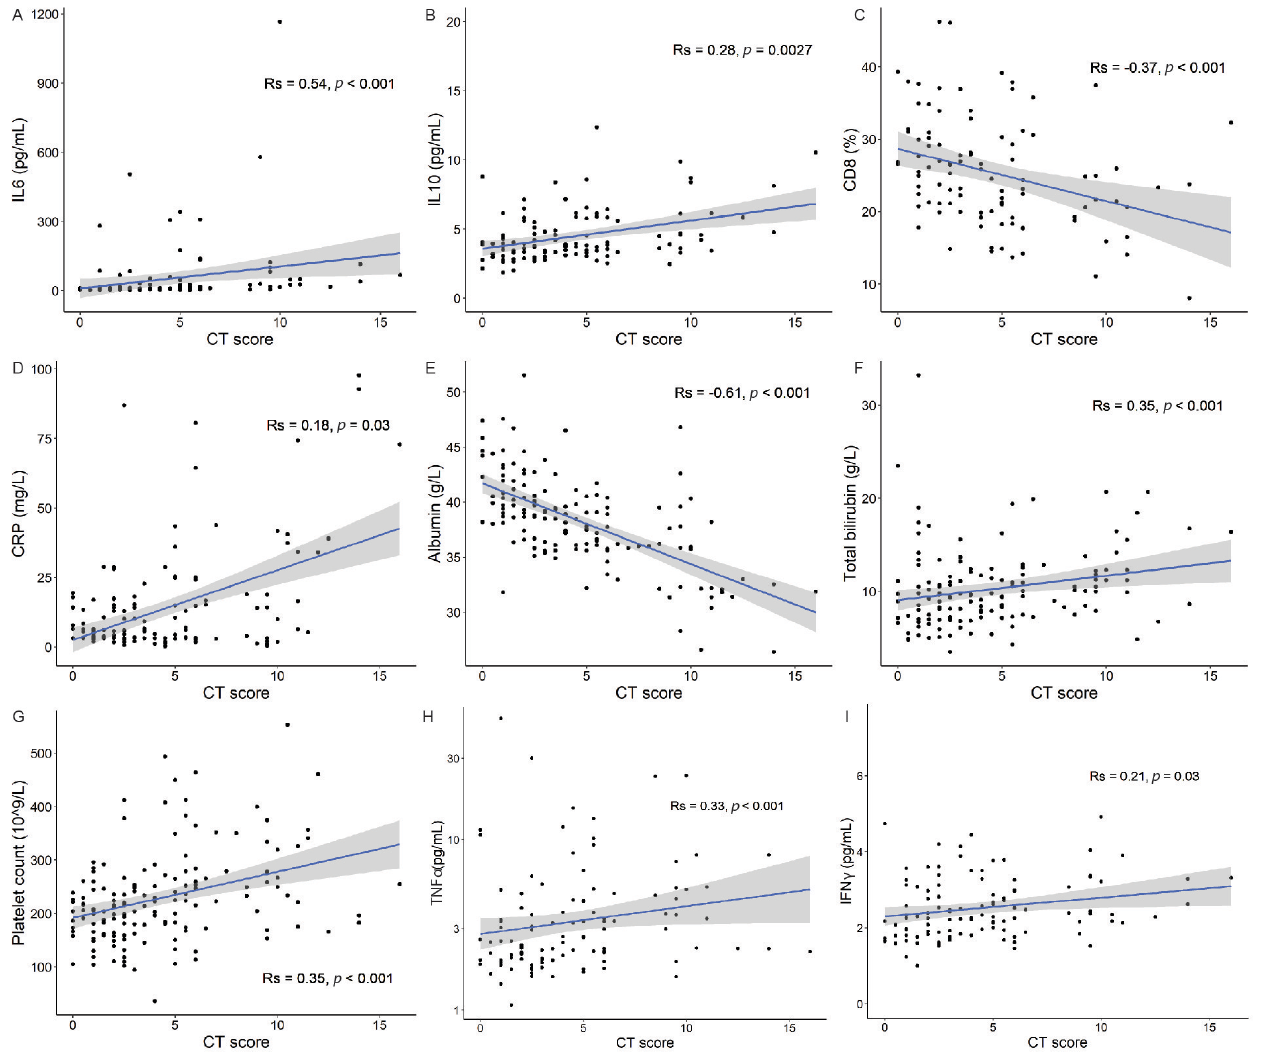
Figure 4. The severity of lung abnormalities is associated with specific immune and clinical biomarkers. Scatterplots depicting associations between CT scores and various blood-based biomarkers. Spearman’s correlation coefficients were calculated between CT scores and ( A ) IL-6, ( B ) IL-10, ( C ) CD8+ T cells, ( D ) CRP, ( E ) albumin, ( F ) total bilirubin, ( G ) platelets, ( H ) TNF- α , and ( I ) IFN- γ , as indicated. Shaded areas indicate 95% confidence